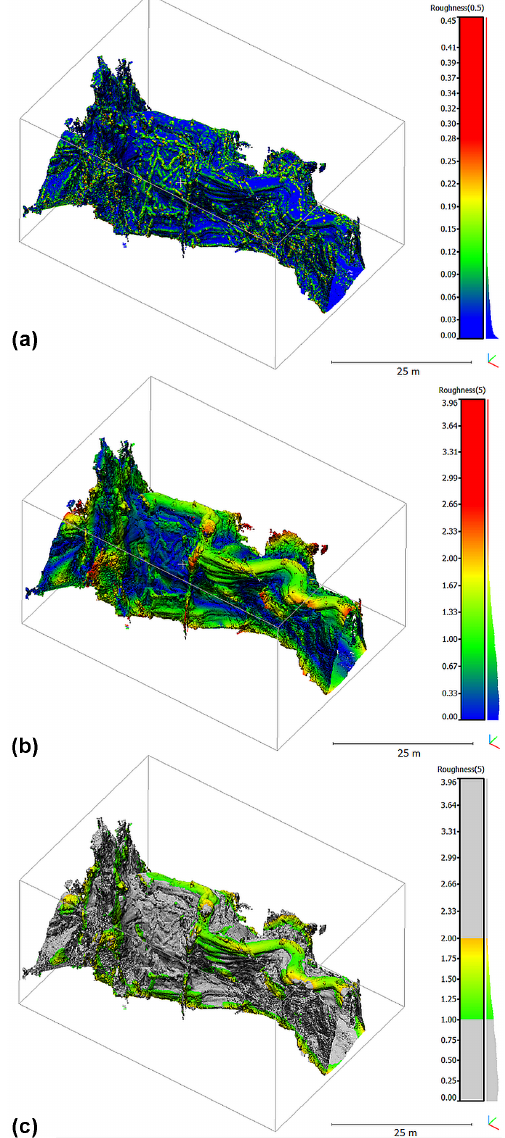
Figure 16. Roughness of the 3-D cave surface model in the Gothic Dome derived at 0.5m scale (a) , and 5m scale (b) , and selection of speleoforms having values between 1 and 2 (c) , respectively.